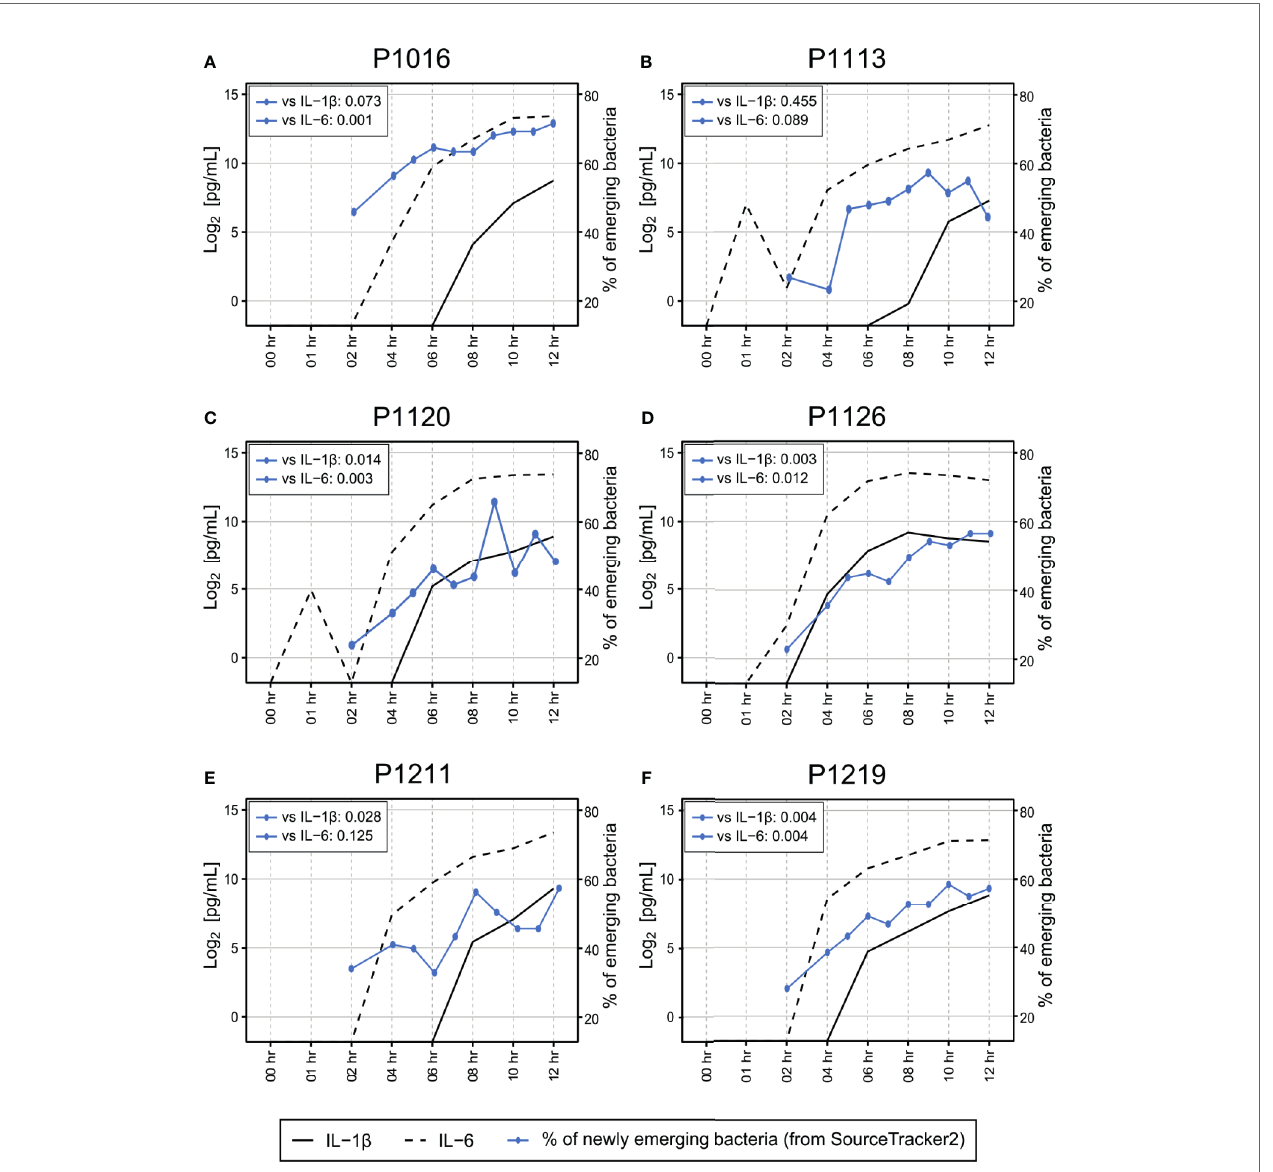
FIGURE 6 | (A – F) Association between cytokine induction and introduction of new bacterial species into the bloodstream. Measurement of IL-1 b and IL-6 levels in the blood revealed that most animals began to develop septic responses between 4 and 8 h after fecal induction. The proportion of newly emerging bacteria was determined by SourceTracker2 ( Figure 2 ) by comparing the altered microbiome with the microbiome detected before peritonitis induction. The original cytokine data were published previously (Park et al., 2019). Pearson correlation coef fi cient p-value was calculated to verify the correlation between the newly emerging bacteria and cytokine